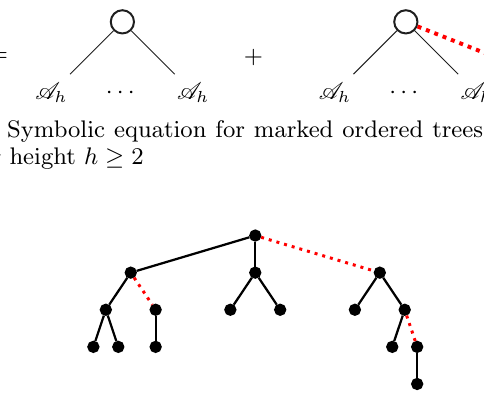
Figure 3. Example of a marked ordered